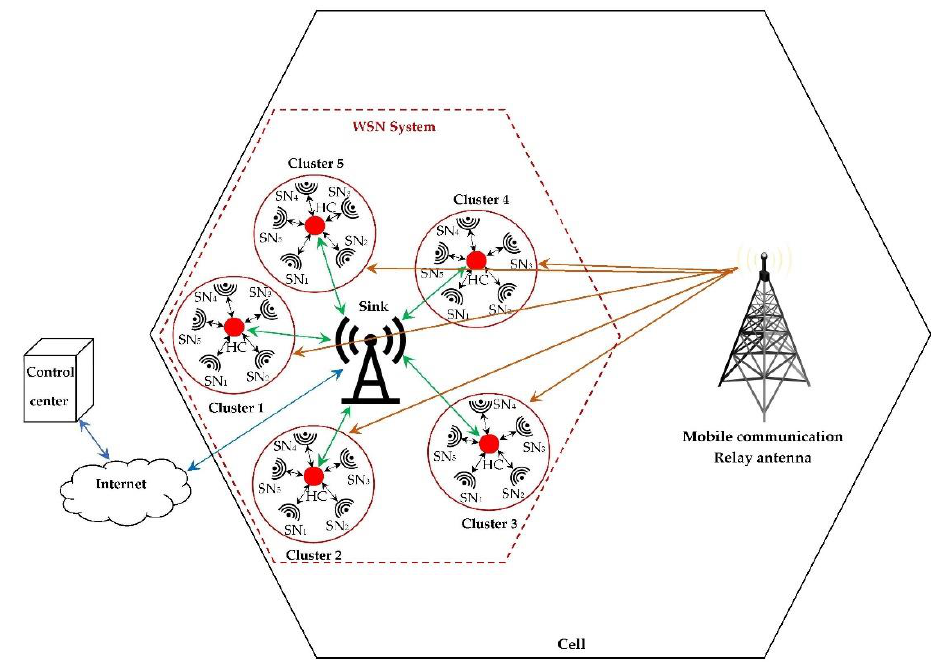
Figure 36. WSN system architecture within mobile communication cell .